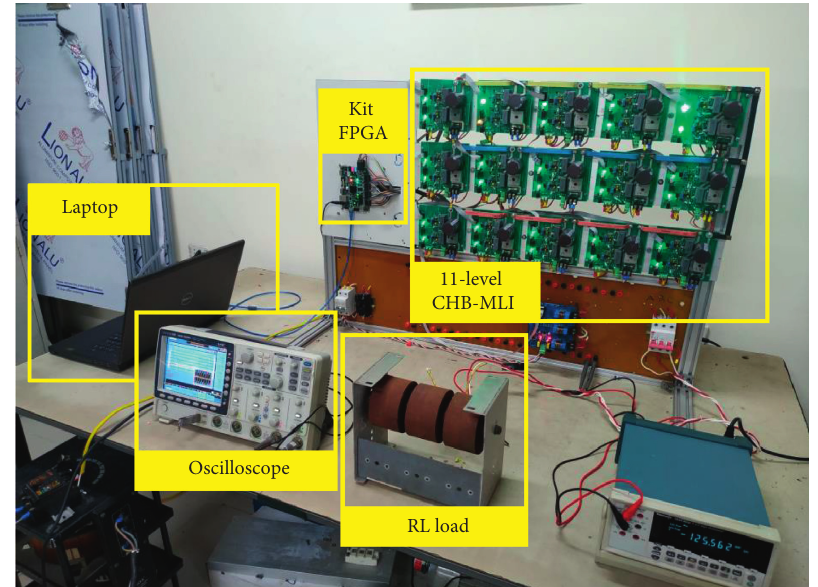
Figure 13: Laboratory experimental setup.